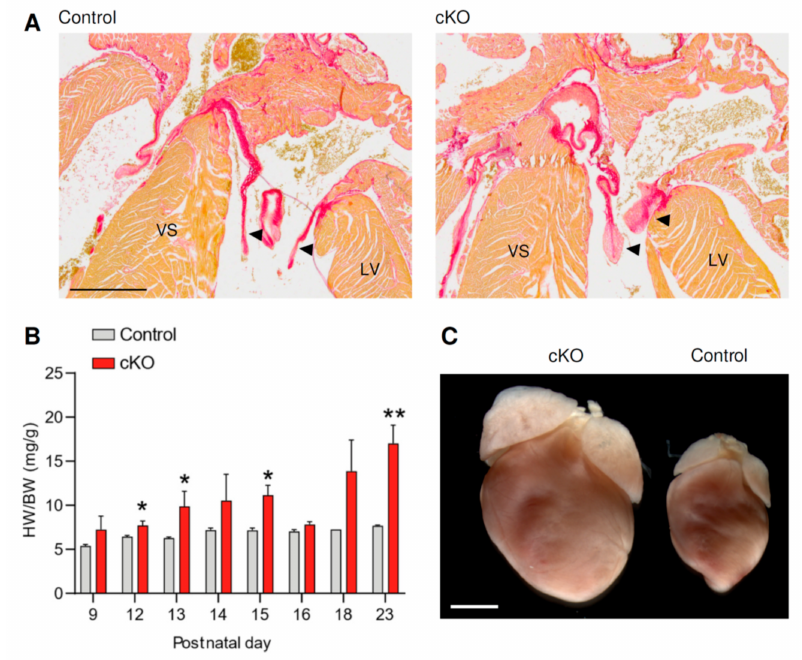
Figure 1. ( A ) Picrosirius red staining shows mitral valves of hearts from control and cKO mice at postnatal day (P) 12. Scale bar indicates 0.5 mm. VS: ventricular septum, LV: left ventricle. Arrowheads indicates mitral valves. ( B ) Hearts of cKO mice at P20 are enlarged. Scale bar indicates 2 mm. ( C ) Heart-weight-to-body-weight ratio (HW/BW) of control and cKO mice at different postnatal stages. * p < 0.05, ** p < 0.001 (unpaired Student’s t